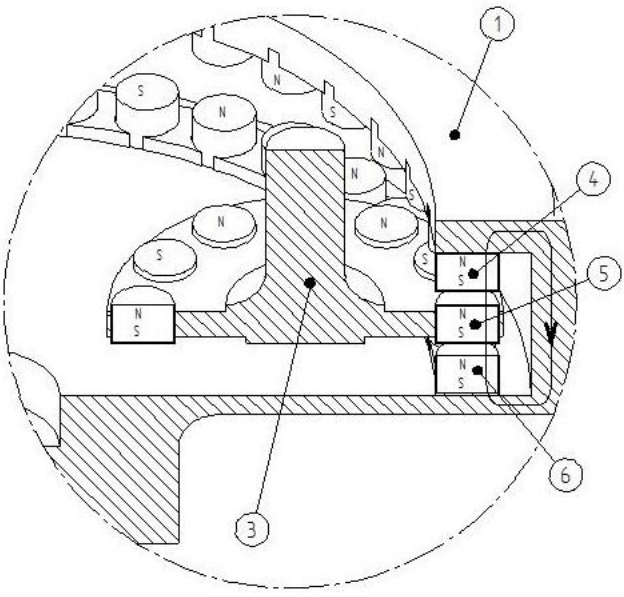
Figure 1. Scheme of magnet meshing.